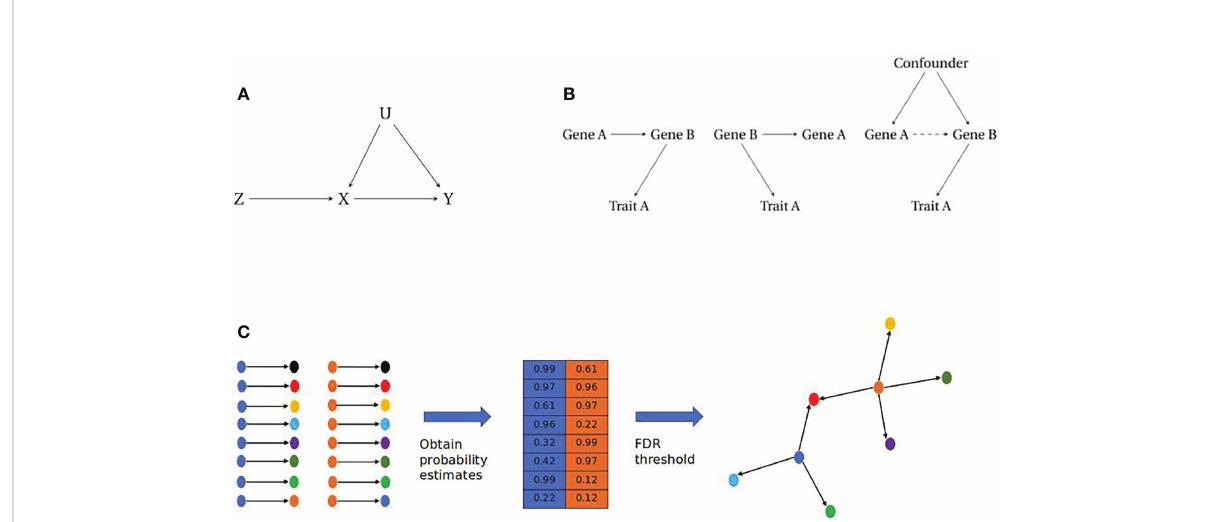
FIGURE 2 (A) Instrumental Variable paradigm. The instrumental variable (Z) is causally associated with the exposure (X) which in turn is causally associated with the outcome (Y). The IV will account for any confounding (U) that affects the exposure or outcome, assuming independence of U. (B) Causal modelling of pairwise gene-gene relationships. (Left) Simple causal model where Trait A is in fl uenced by Gene A, through Gene B (Middle) Reactive model where Gene B in fl uences both Gene A and Trait A, therefore any association between Gene A and Trait A is a non- causal relationship. (Right) Association between Genes A and B is a result of unobserved confounding, therefore there is no causal relationship between Gene A and Trait A. (C) Reconstructing gene networks from pairwise relationships. (Left) Prospective pairwise relationships between genes with a robust eQTL (blue and orange) and other genes within a dataset. (Middle) Causal inference approaches are employed to obtain a probability matrix for the likelihood of a causal relationship between gene pairs. (Right) A fi ltering step is imposed e.g. a False Discovery Rate (FDR) cut-off, which will return relationships that cross this threshold to be assembled as directed